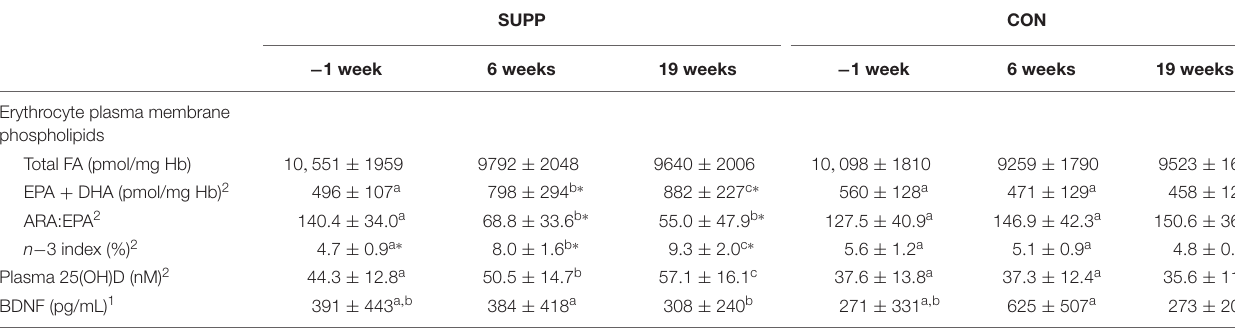
TABLE 2 | Blood analyses and nutrient bioavailability.